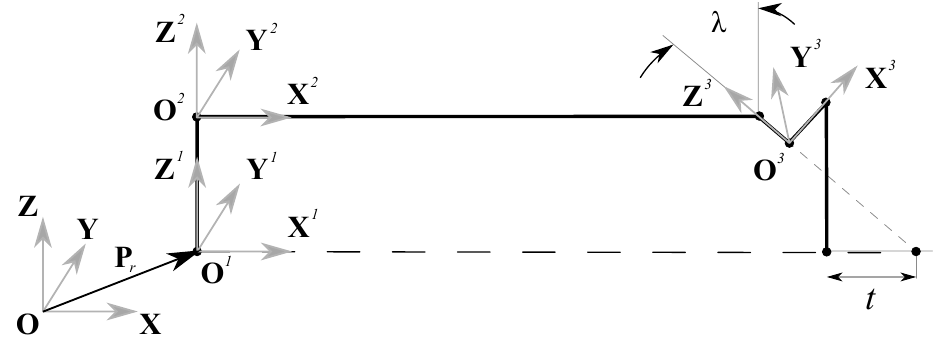
Figure 3. Reference frames of the two-wheeled vehicle